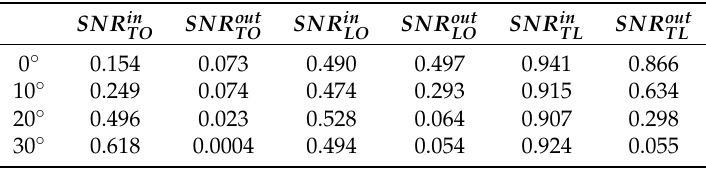
Table 2. SNR values calculated from the experimental error